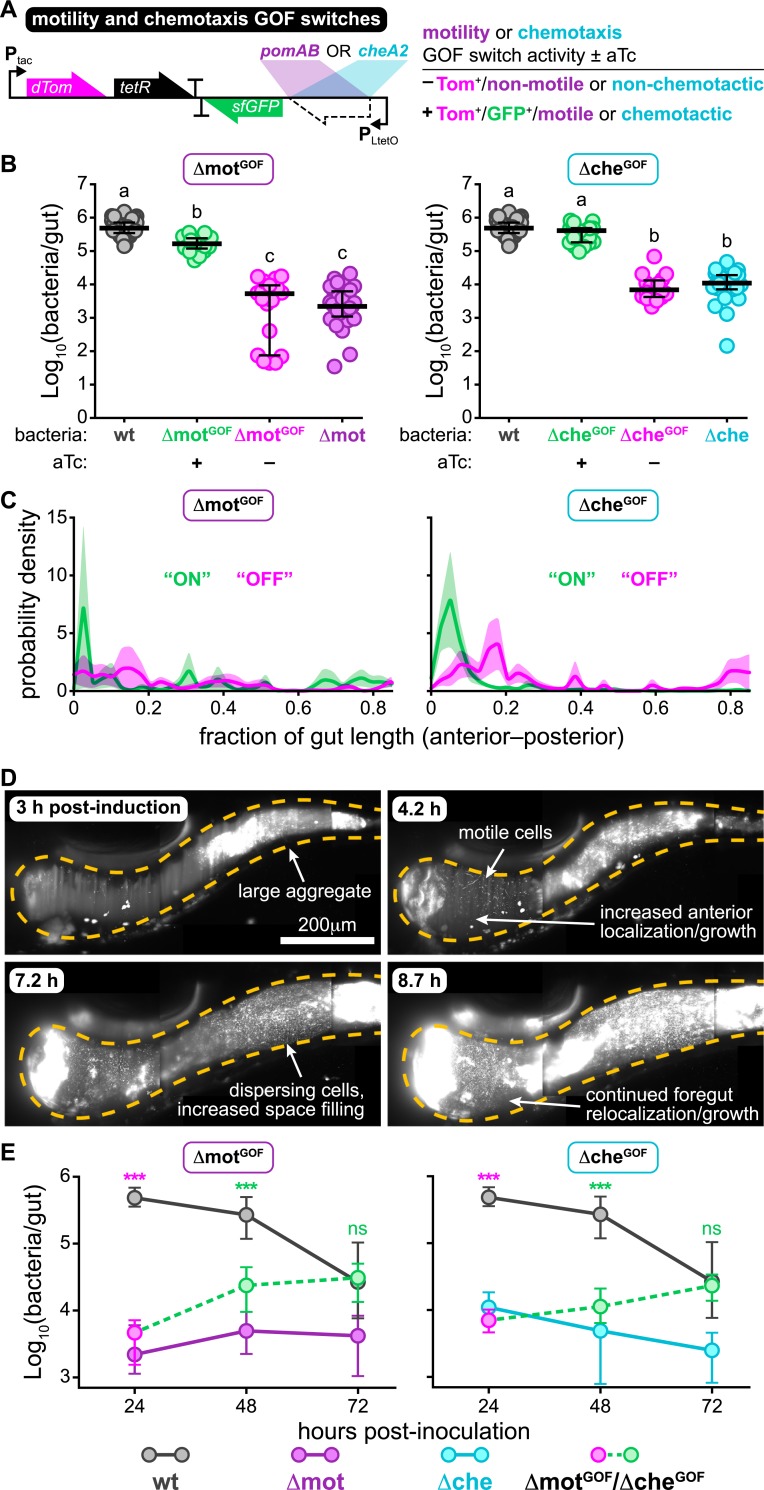
Acquisition of swimming motility or chemotaxis leads to rapid recovery of intestinal spatial organization and abundance.(A) Schematic of the motility and chemotaxis GOF switches. Table summarizes switch activity and bacterial behaviors +/− aTc. (B) ΔmotGOF or ΔcheGOF abundances 24 hpi +/− aTc. ΔmotGOF and ΔcheGOF were preinduced overnight in liquid culture prior to inoculation; aTc was maintained in the water for continuous switch activation. Abundances of wild-type Vibrio, Δmot, and Δche in wild-type hosts (from Fig 1A, 24 hpi) are shown for comparison. Bars denote medians and interquartile ranges. Letters denote significant differences. p < 0.05, Kruskal-Wallis and Dunn’s multiple comparisons test. (C) Probability densities showing the spatial distributions of ΔmotGOF and ΔcheGOF at 24 hpi. Magenta = uninduced; green = induced. Shaded regions mark standard errors. Sample sizes (populations within individual animals): ΔmotGOF “OFF”, n = 5; ΔmotGOF “ON”, n = 7, ΔcheGOF “OFF”, n = 6; ΔcheGOF “ON”, n = 6. (D) Maximum intensity projections acquired by LSFM from the same animal showing ΔcheGOF undergoing rapid changes in spatial organization following induction. Dashed lines mark approximate intestinal boundary. (E) Abundances of ΔmotGOF and ΔcheGOF over time. Magenta and green circles indicate abundances +/− aTc, respectively. Plotted are medians and interquartile ranges (n ≥ 19 animals/marker). Abundances of wild-type Vibrio, Δmot, and Δche (from Fig 1A) are shown for comparison. Significant differences between each mutant and wild-type determined by Mann-Whitney (magenta asterisks: uninduced; green asterisks: induced). ***p < 0.0001. Underlying data plotted in panels B, C, and E are provided in S1 Data. aTc, anhydrotetracycline; GOF, gain-of-function; hpi, hours post induction; LSFM, light sheet fluorescence microscopy; ns, not significant.